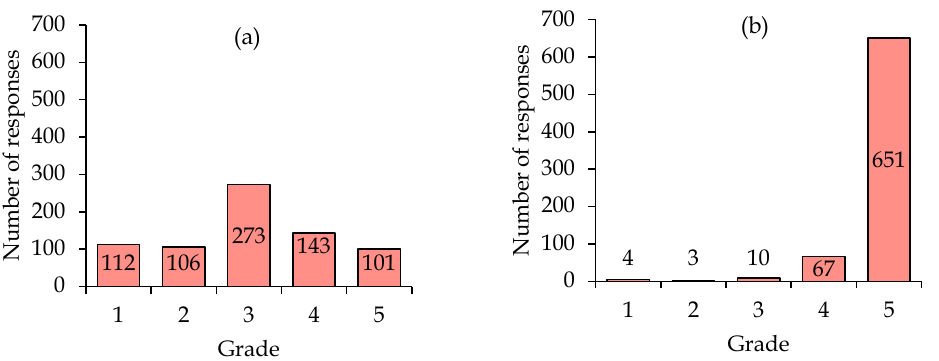
Figure 10. Responses on ( a ) the change of frequency of visits in the UGAs change after the end (May 2020) of COVID-19 restrictions (research question: “How has the frequency of your visits in the UGAs changed after the end (May 2020) of the COVID-19 restrictions?” and ( b ) importance of UGAs, regarding the improvement of human health (research question: “How important do you consider UGAs to be, regarding the improvement of human health?”) (grading scale: 1 = minimum to 5 = maximum).